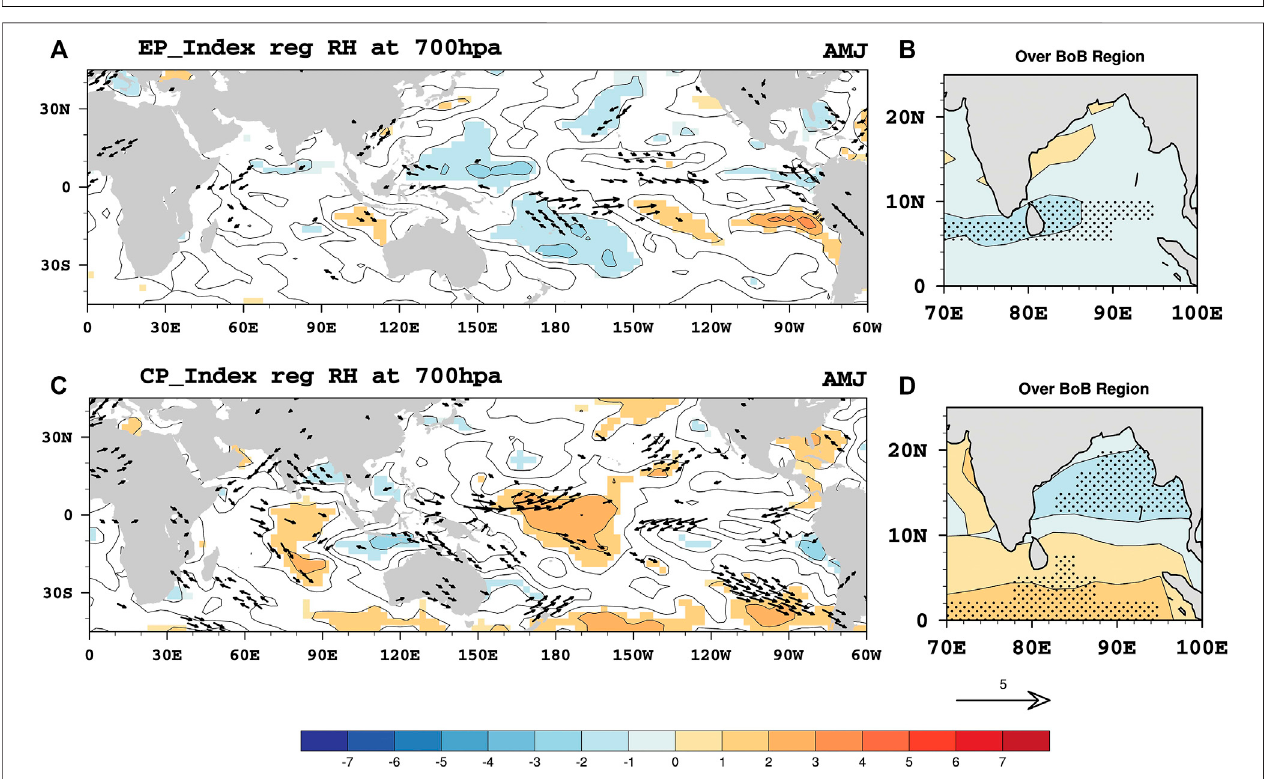
FIGURE 15 | (A) Regressed relative humidity at 700 hPa and wind at 850 hPa in AMJ with the EP index at global scale and, (B) over the BoB. (C,D) Same as the upper panel but for the CP index. Shading indicates positive (negative) signi fi cance at the 95% level. Vectors are statistically signi fi cant at the 90% level.